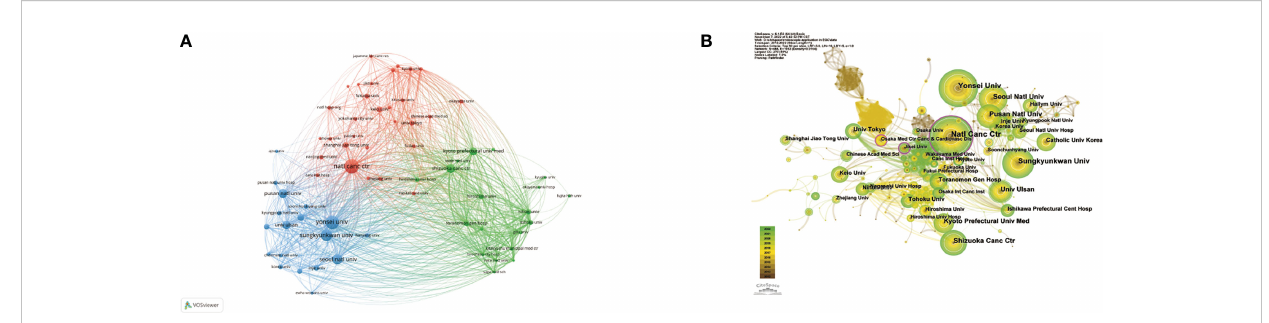
FIGURE 5 (A) Network visualization of the institutions with more than 10 publications. (B) Network visualization map of institutional collaboration analysis. Size of nodes and thickness of linkages signify publication counts and connection strength. The nodes with an outer purple ring reveal high centrality.